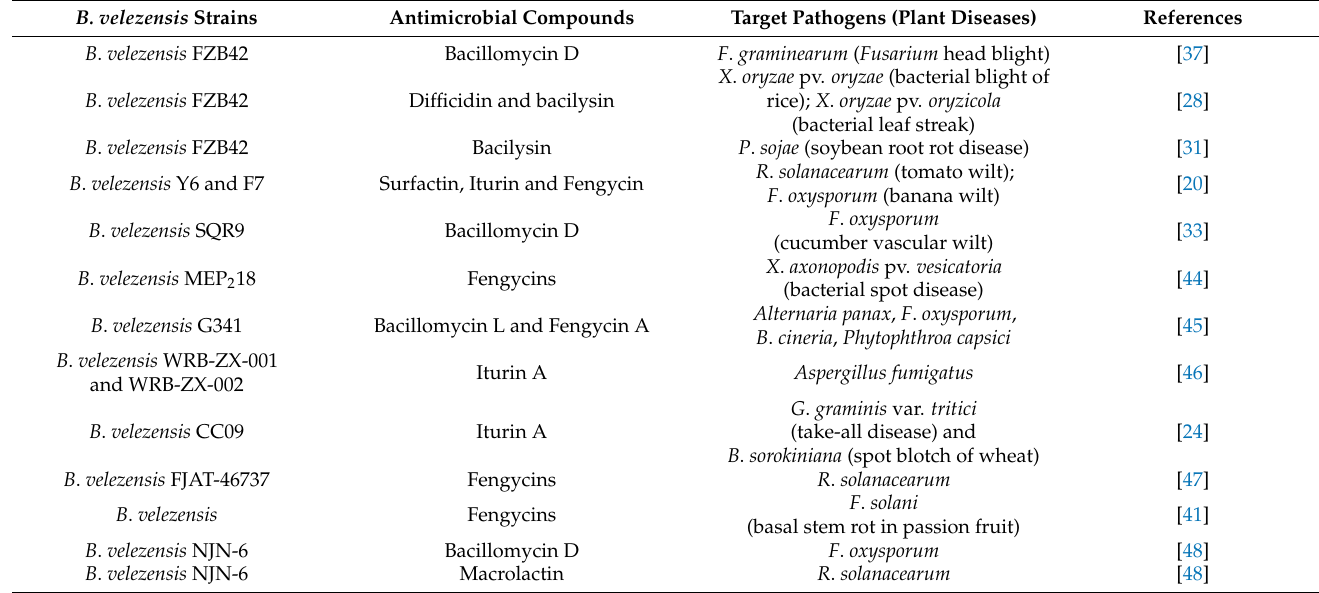
Table 2. Antimicrobial compounds from B. velezensis acting against